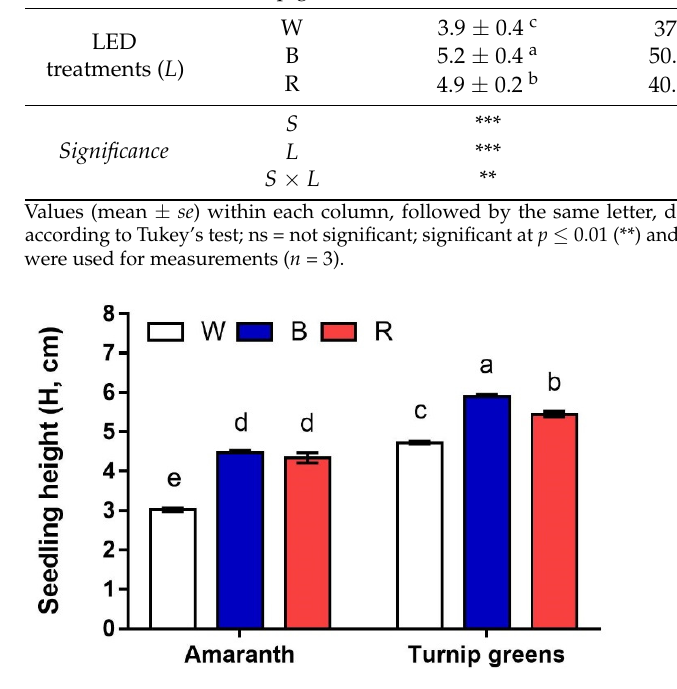
Figure 1. Interaction effect of species × light treatment (W = white, B = blue, R = red) on seedling height (H, cm) of microgreens. Data are means ± standard error ( n = 3). Three biological replicates were used for the measurements. Different letters indicate significance at p ≤ 0.05 according to Tukey’s test.